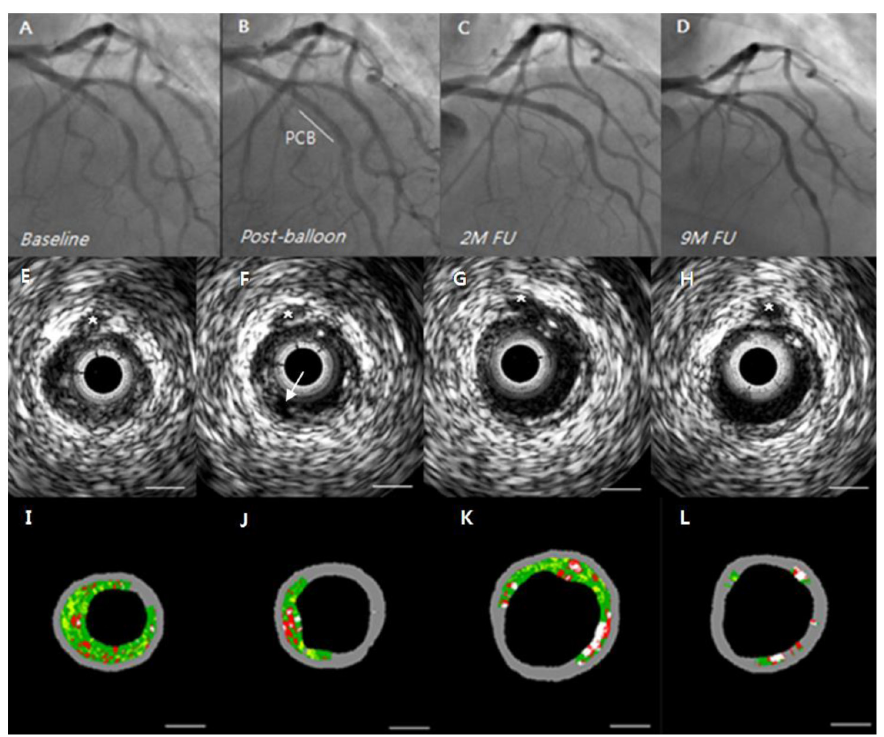
Fig 5. A representative case of paclitaxel-coated balloon treatment in a de novo lesion. A 67-year-old woman who had unstable angina with near total occlusion of the left anterior descending coronary artery (A) underwent paclitaxel-coated balloon (PCB) treatment after plain balloon angioplasty (POBA). After POBA, the lesion showed minimal residual stenosis including a non-flow-limiting type A dissection (B). The patient experienced no procedural-related complications and was discharged without symptoms after the procedure. She took dual antiplatelet therapy for 6 weeks followed by aspirin alone. Serial intravascular ultrasound virtual histology was performed right after POBA and at 2 months and 9 months follow-up. After POBA, the lesion was well expanded with dissection of plaque seen on IVUS (F). At 2 months, IVUS demonstrated an enlarged lumen accompanied by a slightly enlarged vessel (G). At 9 months, the lumen and vessel were both well preserved (H). The plaque phenotype, fibroatheroma remain unchanged and the plaque burden (PB) decreased over time (I; 66%, J; 50%, K; 47%, L: 40%). Plaque burden (%) was defined as P&M area divided by EEM area x 100. Asterisks and arrows indicate a small septal branch and a dissected flap, respectively. Bar = 1